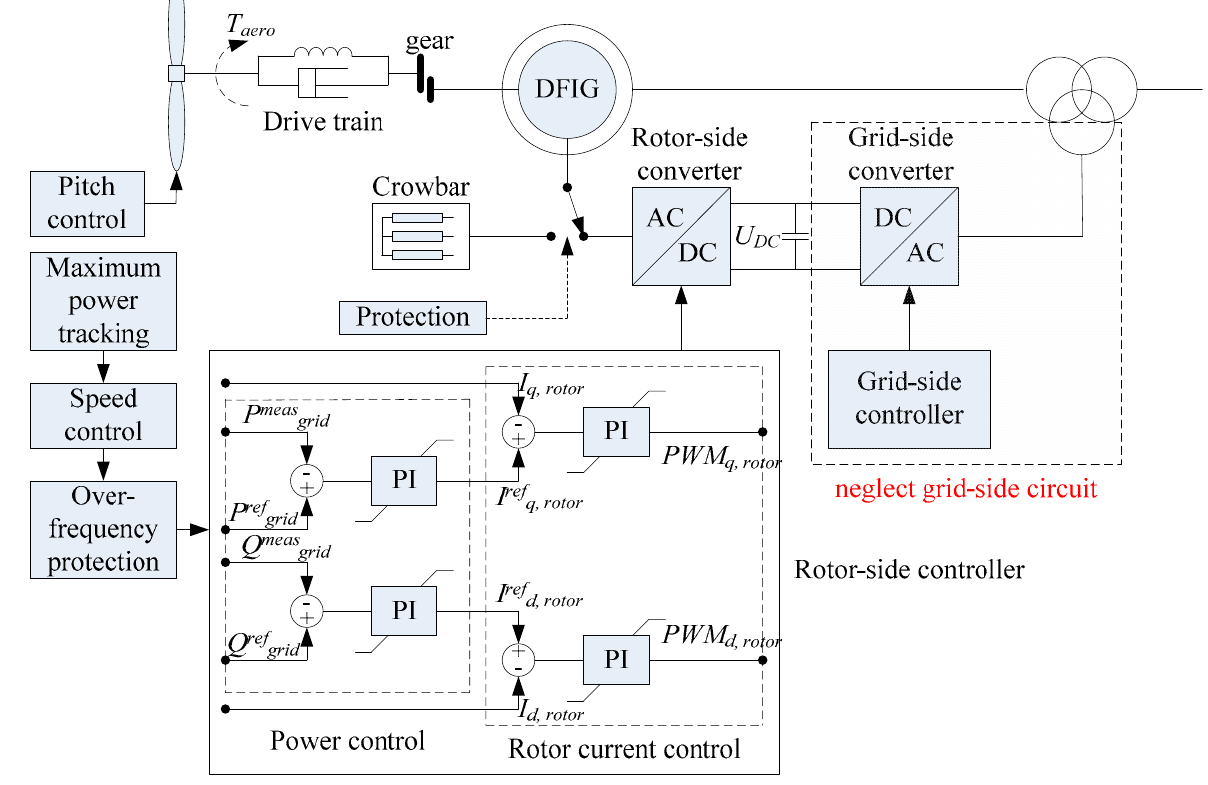
Figure 3. DFIG model.